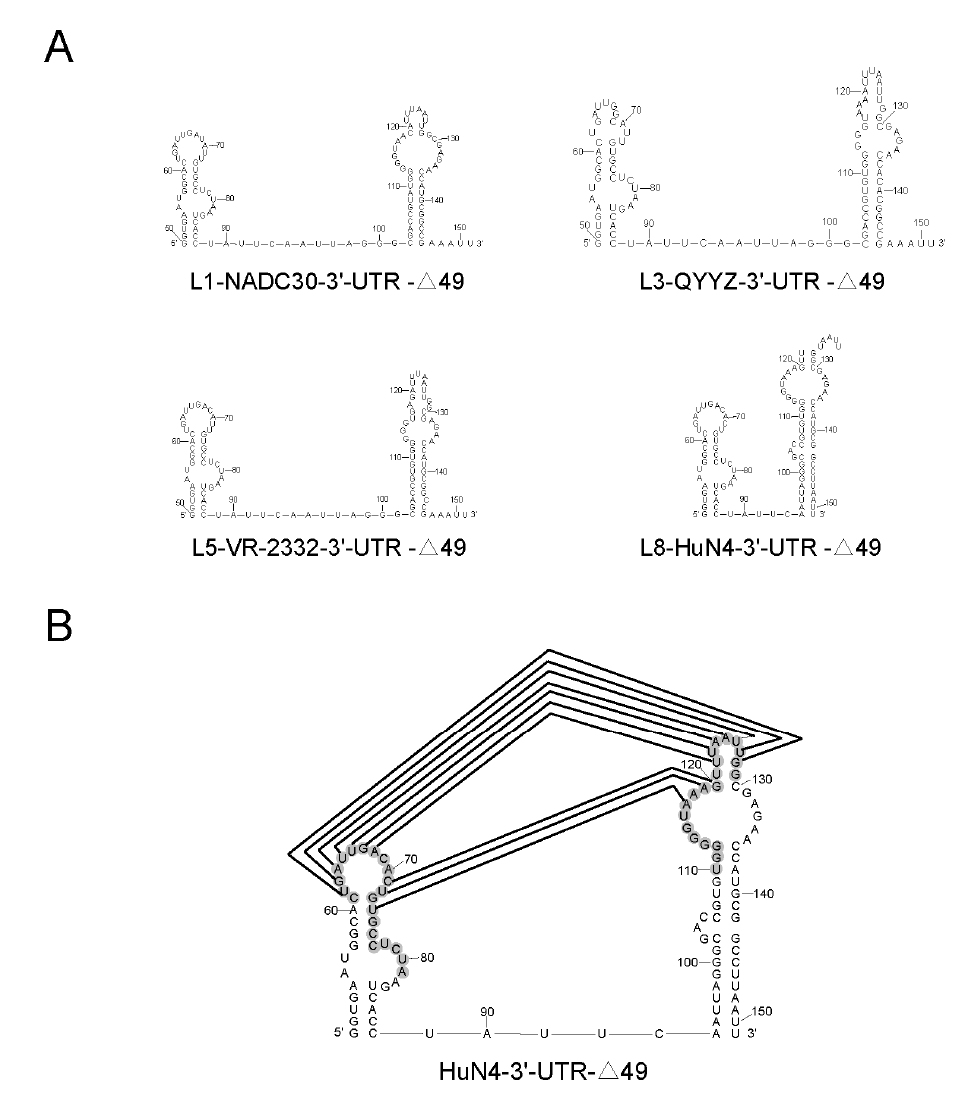
Figure 7. The pseudoknot structure in the 3 ′ -UTR. ( A ) A possible pseudoknot in the 3 ′ -UTR was formed and involved in PRRSV replication after deleting the 49 nucleotides at the 5 ′ -terminal of 3 ′ -UTR. The truncated 3 ′ -UTR secondary structures of L1-NADC30, L3-QYYZ, L5-VR-2332 and L8-HuN4 are shown. ( B ) The nucleotides involving in the formation of pseudoknot are depicted in gray, and base–pairing interaction is depicted by lines. The predicted pseudoknot structure was based on the 3 ′ -UTR sequence of PRRSV HuN4.